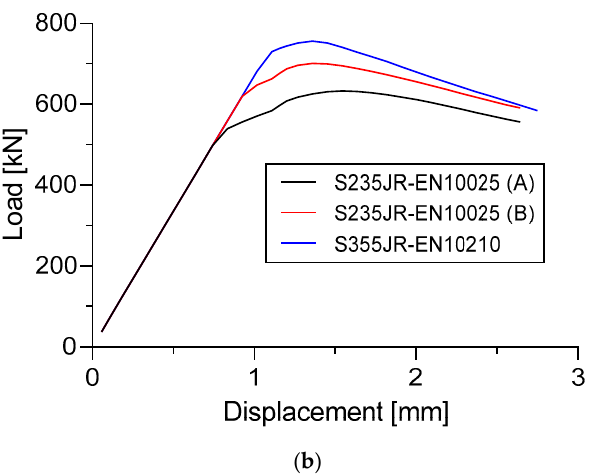
Figure 26. Effect of materials change to the load versus displacement curve. ( a ) Specimen A; ( b ) Specimen B.